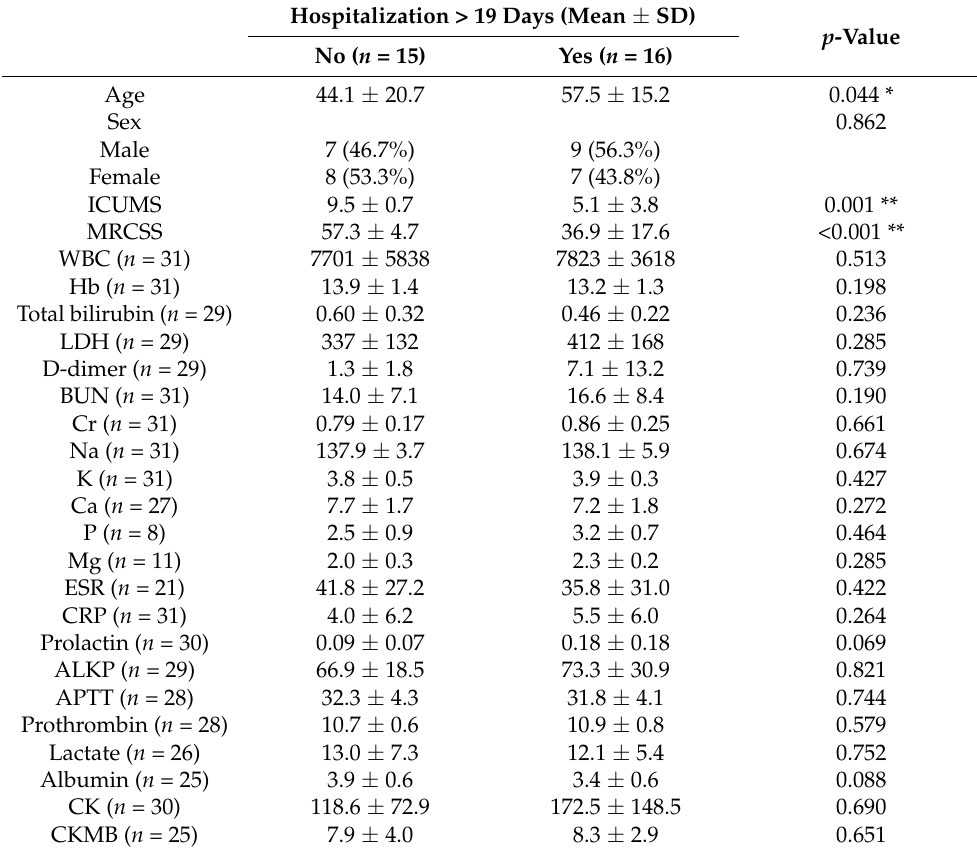
Table 3. The comparison of clinical characteristics and initial blood profiles between the groups based on the length of hospital